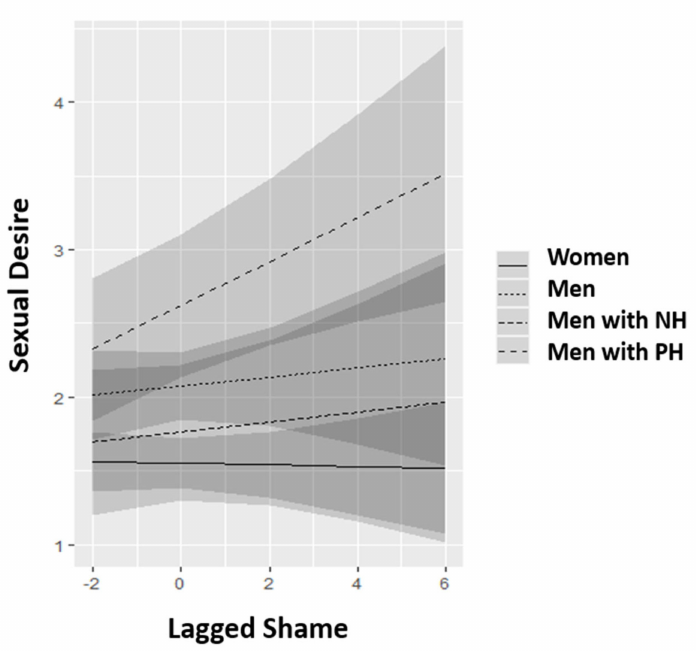
Figure 2. The effect of lagged shame on current sexual desire for women, men, men with NH, and men with PH. Only for men with PH an increase in the preceding shame levels significantly forecasted an increase in current sexual desire. Shaded areas represent 95% confidence